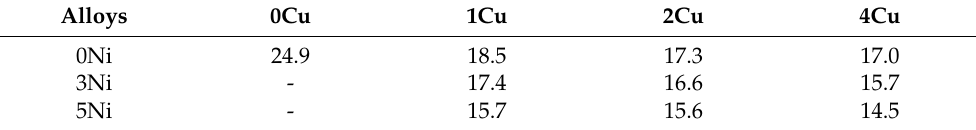
Table 3. The calculated volume fraction (%) of hcp ε -phase in the as-cast CoCrW-xNi-yCu alloys.